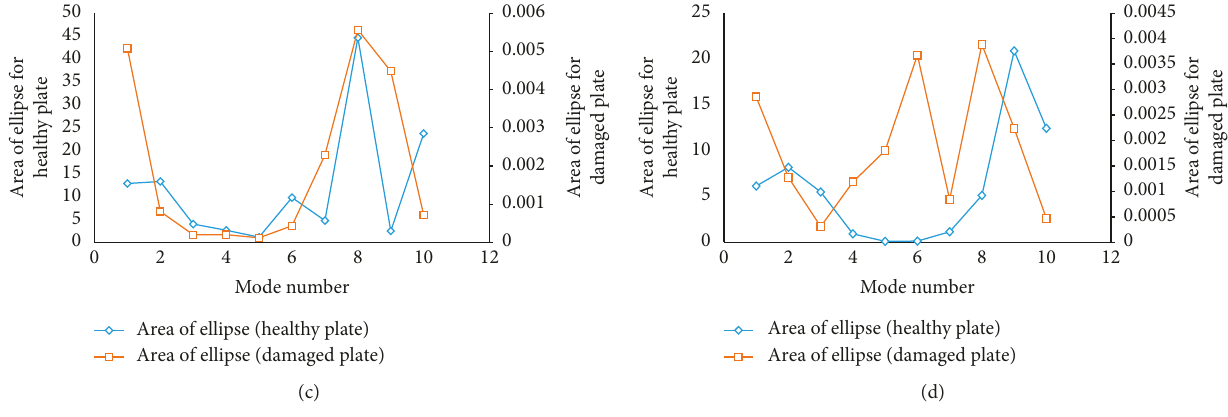
Figure 5: Variation in the area of the ellipse for plates (a) B2, (b) C1, (c) C2, and (d) C3.